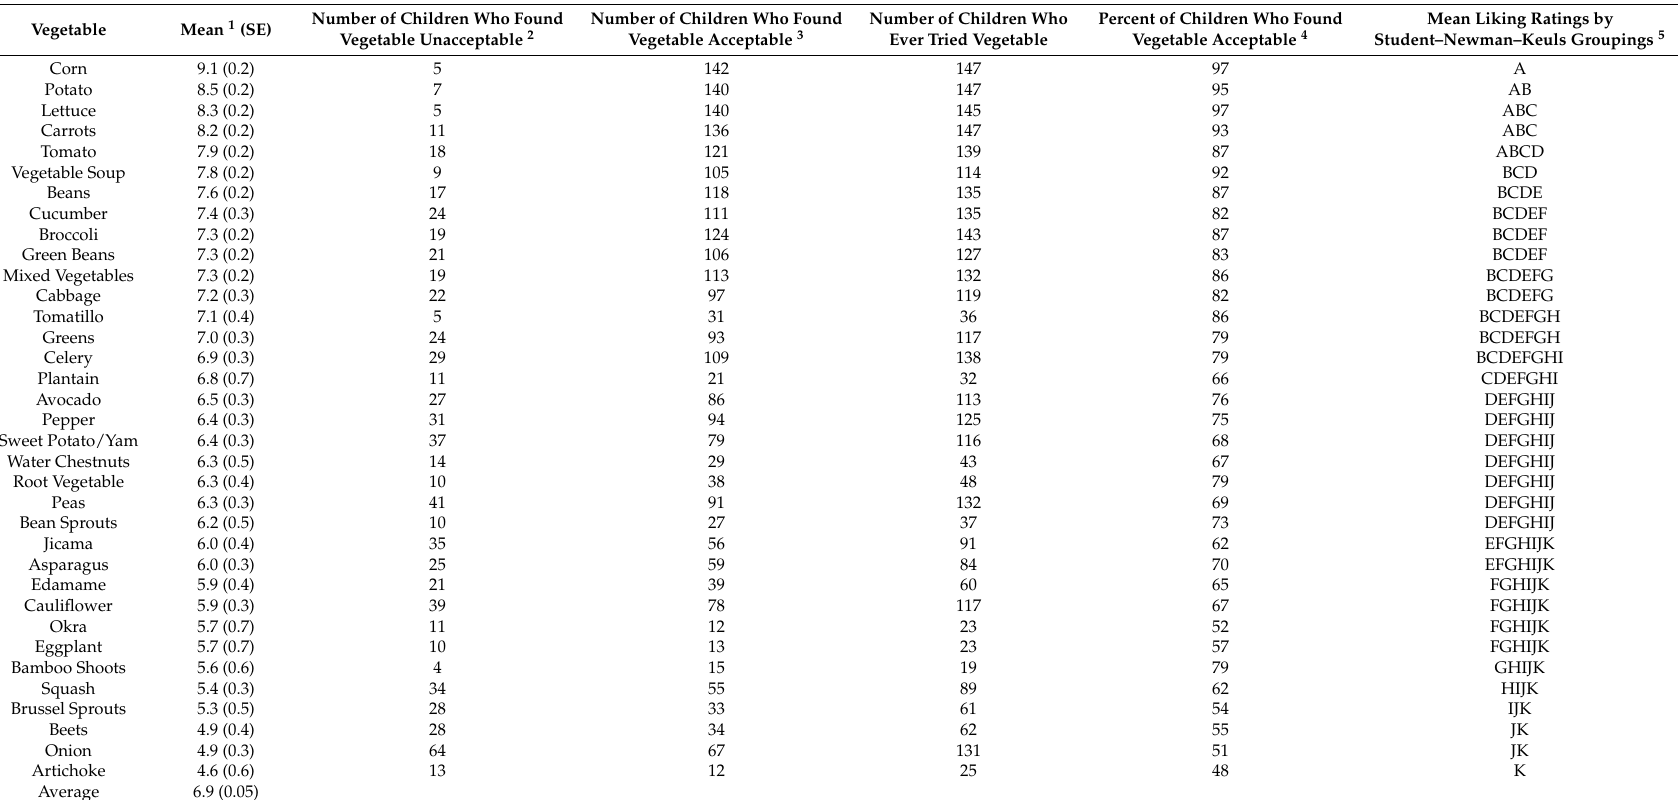
Table 2. Summary of child liking data ( n =